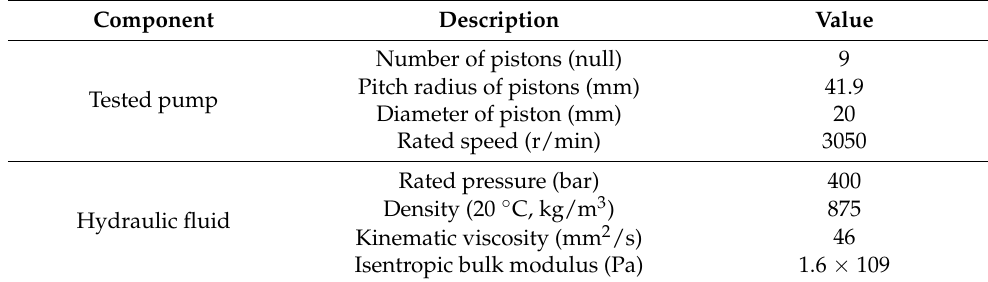
Table 2. Measured parameters of the piston pump.